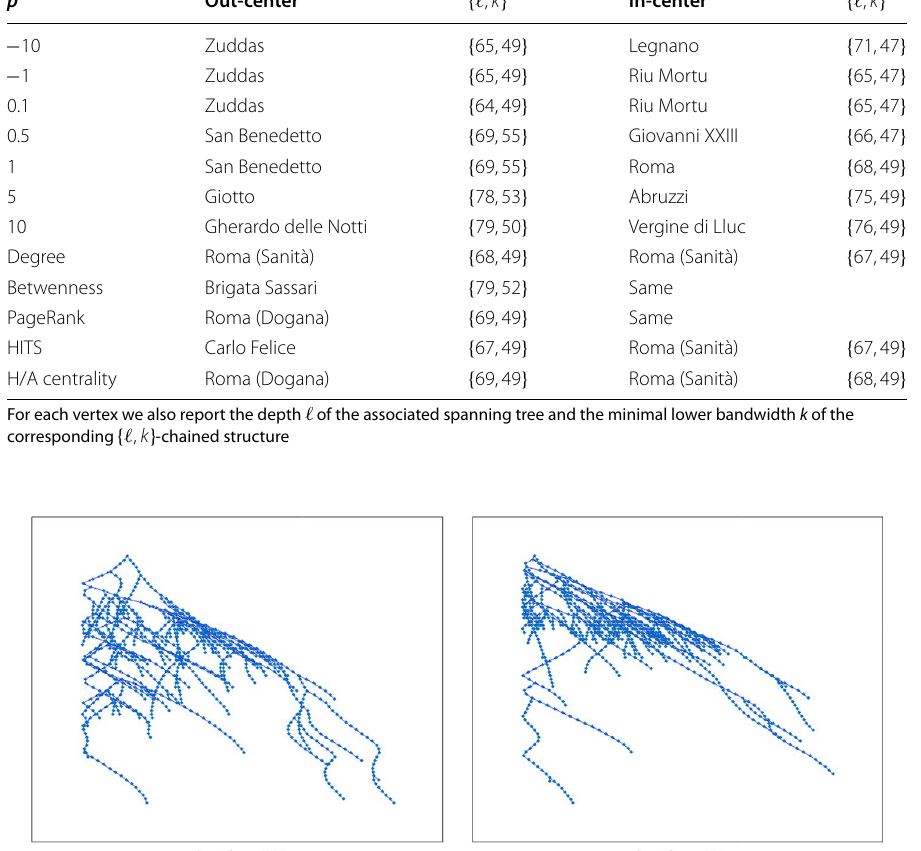
Table 3 Network bus-ca (970 vertices): we report the p -out-center and the p -in-center vertices for different values of p , together with the in/out-centers identified by other centrality measures p